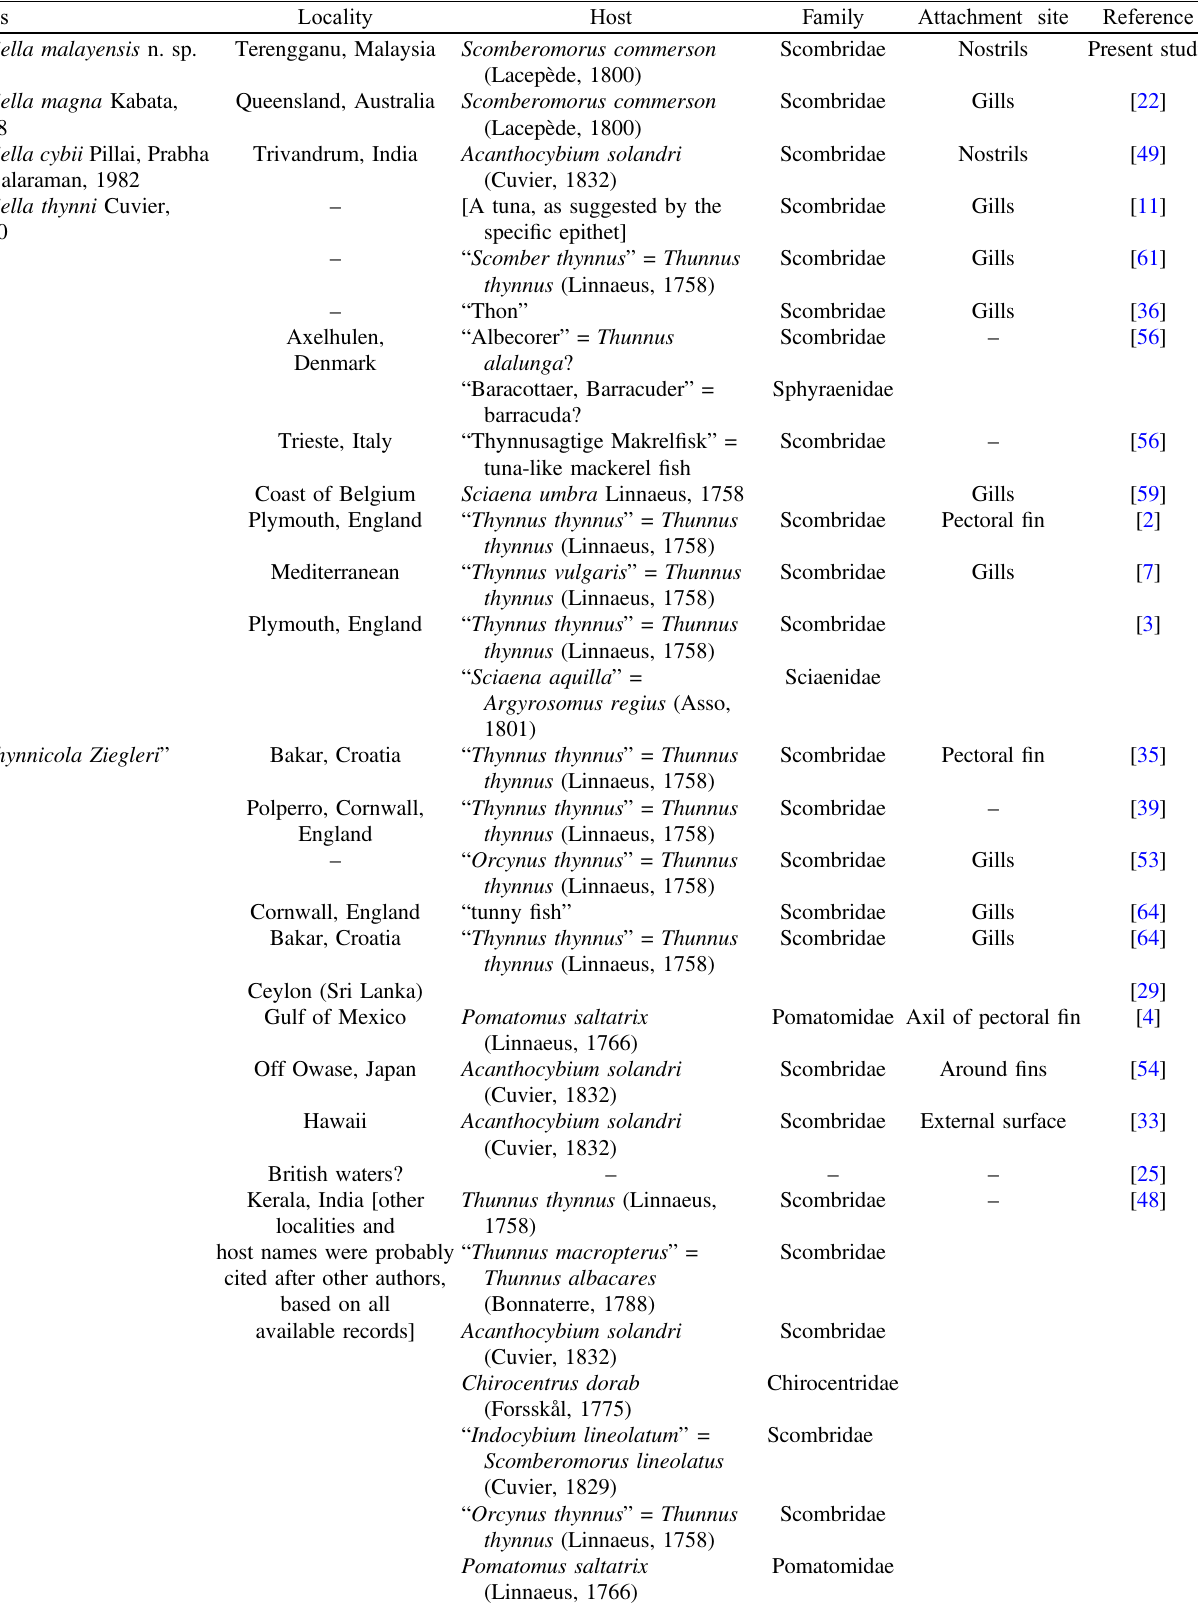
Table 3. A comparison of Brachiella species in terms of their locality, host, and attachment site.